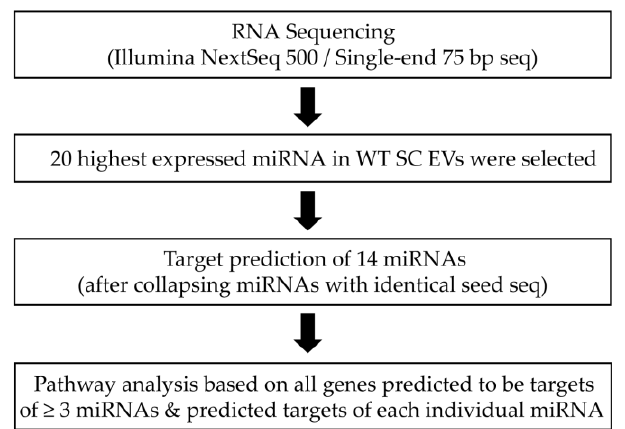
Figure 5. Pipeline for the miRNA analysis in EVs derived from WT SCs.